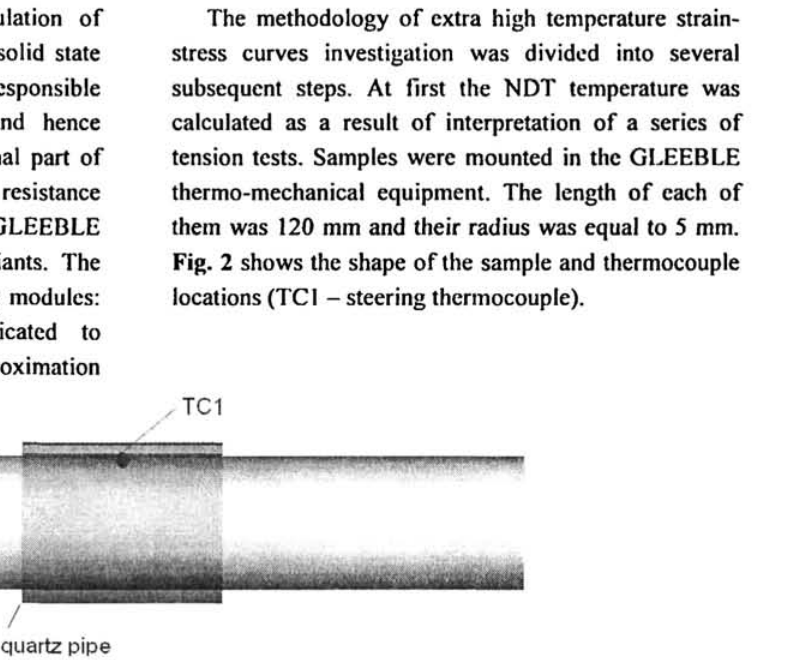
Fig. 2: Scheme of samples used for the experiments. TCI and TC2 - thermocouples.